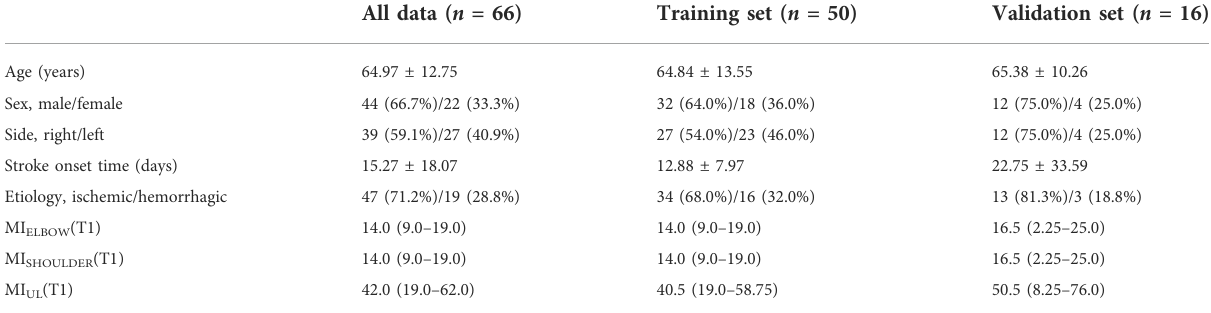
TABLE 1 Sample characteristics at baseline